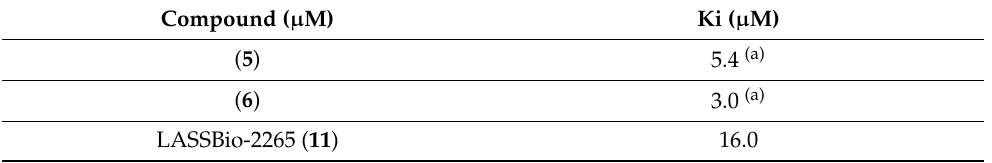
Table 2. CB 2 receptor binding affinity of LASSBio-2265 ( 11 ) and arachidonyl-pyrazolamides ( 5 ) and ( 6